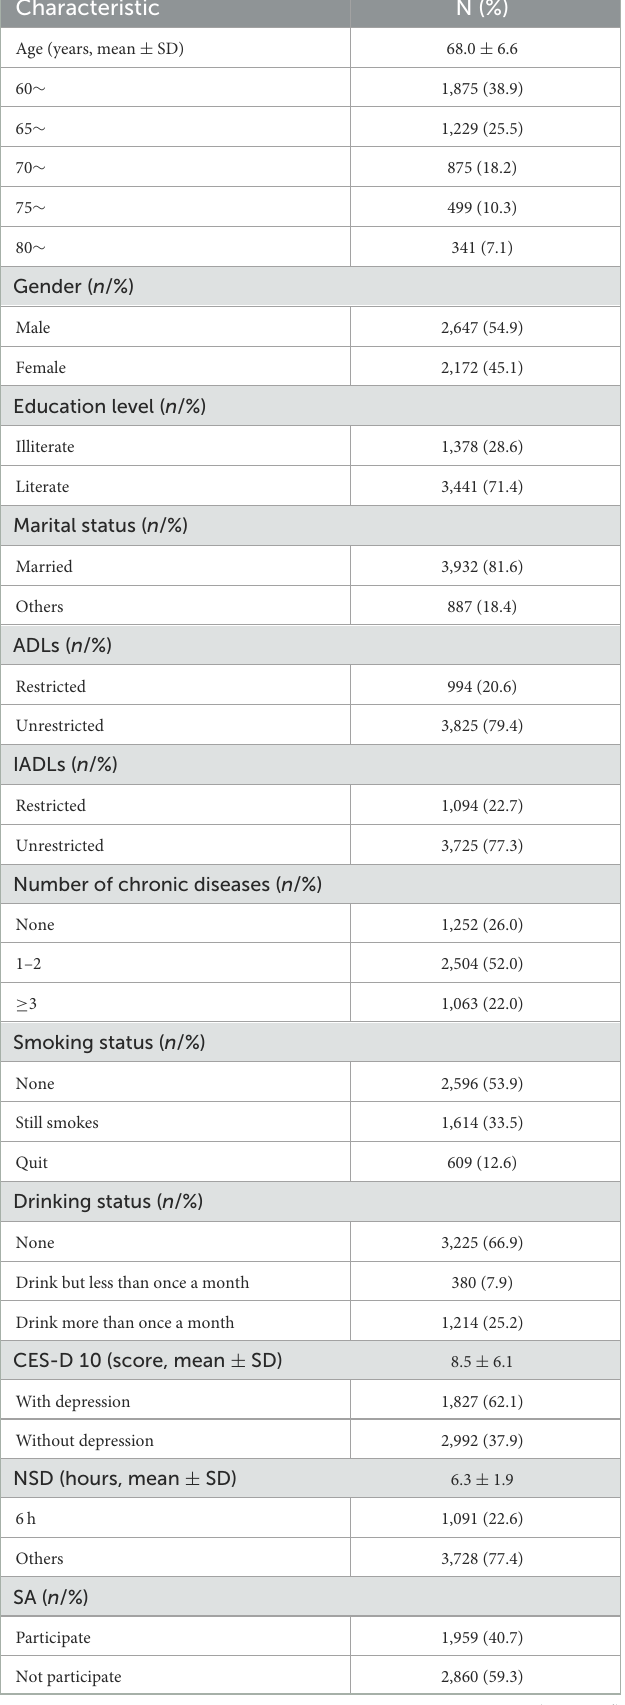
TABLE 1 The distribution of variables at